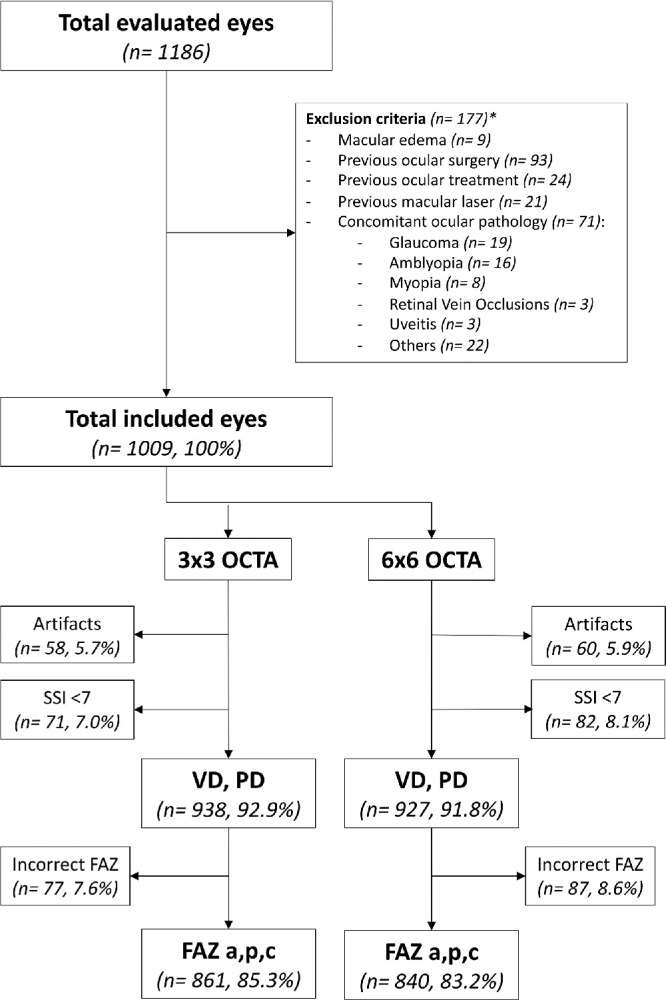
Consolidated standard of reporting trials (CONSORT)-style flow chart describing included and excluded eyes in the study and each individual optical coherence tomography angiography (OCTA) analysis. (*1 eye = ≥ 1 criteria for exclusion; VD = vessel density; PD = perfusion density; FAZ = foveal avascular zone; a = area; p = perimeter; c = circularity; SSI = signal strength index).